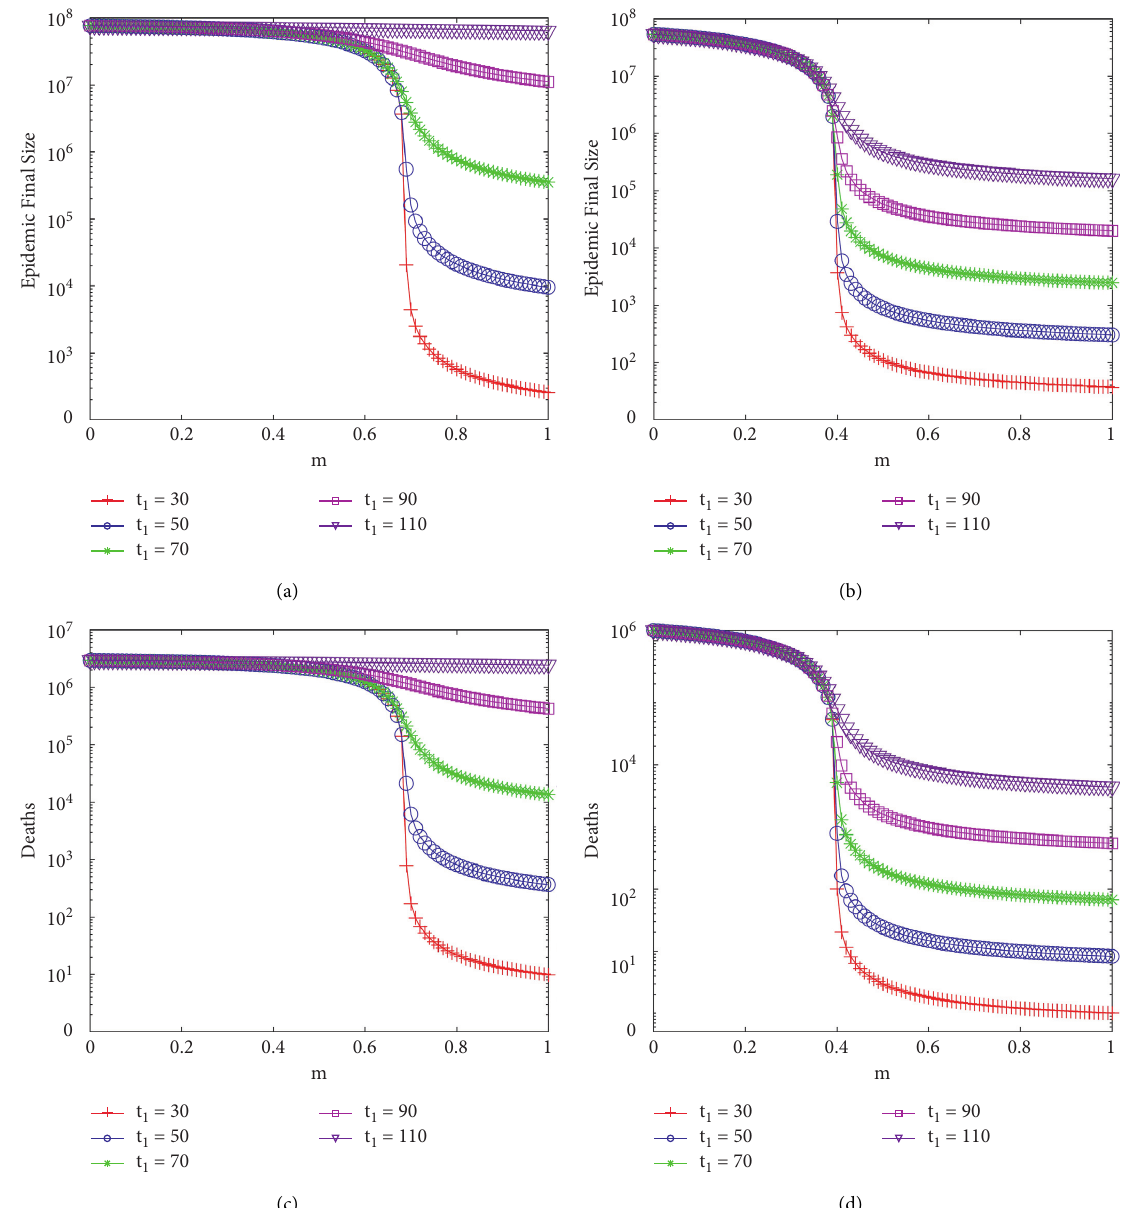
Figure 5: Diagnosis rate ] � 0 . 1 , 0 . 3, respectively. When measures are taken at different times, the epidemic final size and death number vary with the measures intensity. (a) Epidemic final size when ] � 0 . 1; (b) epidemic final size when ] � 0 . 3; (c) death number when ] � 0 . 1; (d) death number when ] � 0 .